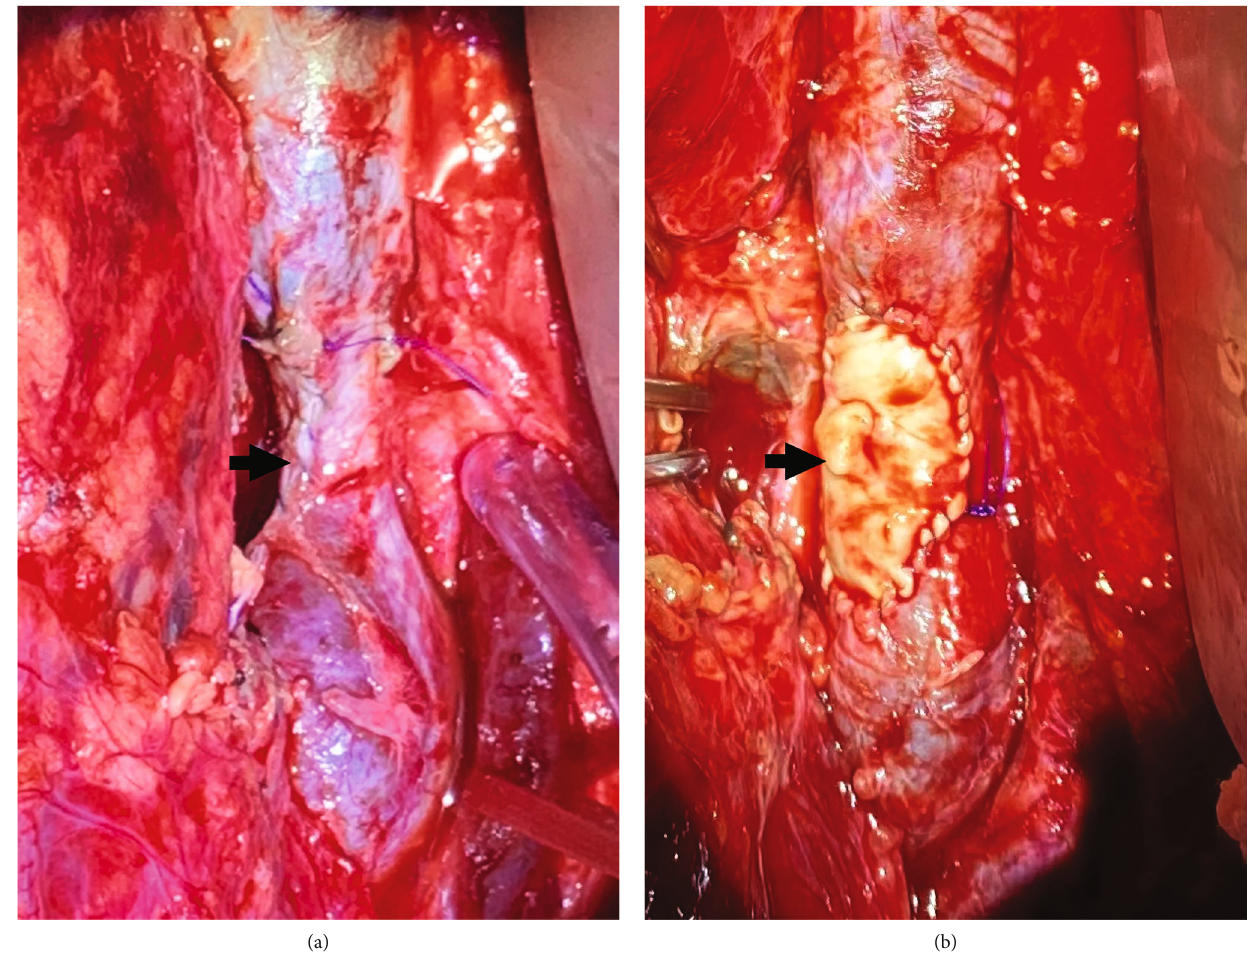
Figure 1: Intraoperative image of IVC: (a) Luminal narrowing status post lateral venorrhaphy prior to patch repair and (b) restored luminal diameter following patch